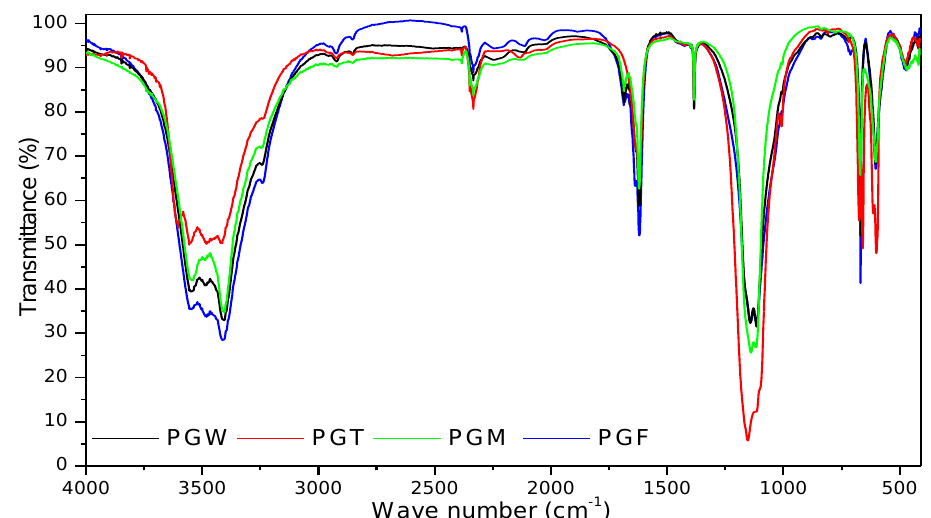
Figure 4. FTIR spectra of the PGF, PGW, PGT and PGM samples.4.4. BET Analysis.